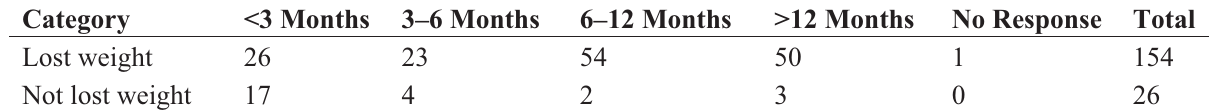
Table 3. Weight loss over various lengths of attendance at MDWMC.